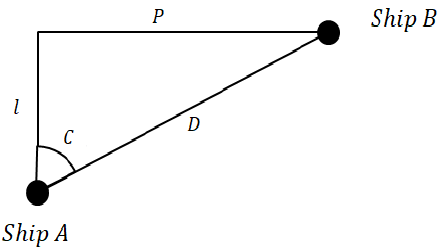
Figure 3. Conceptual diagram for calculating distance.